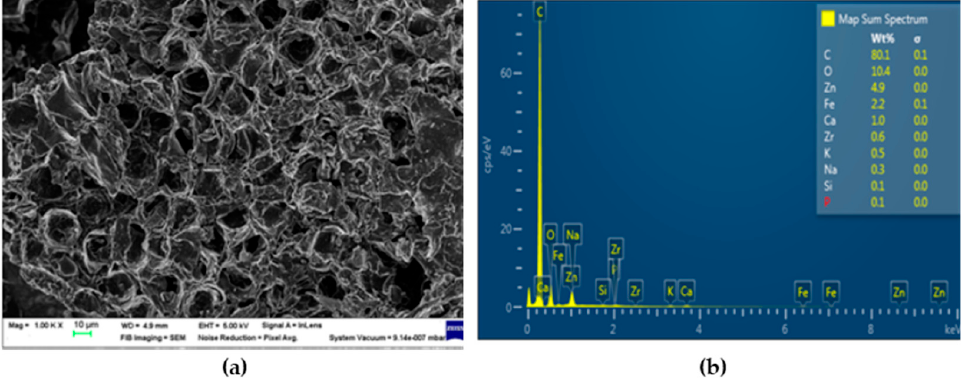
Figure 2. SEM image of PBc ( a ) and corresponding elemental chemical analysis, EDX ( b ).